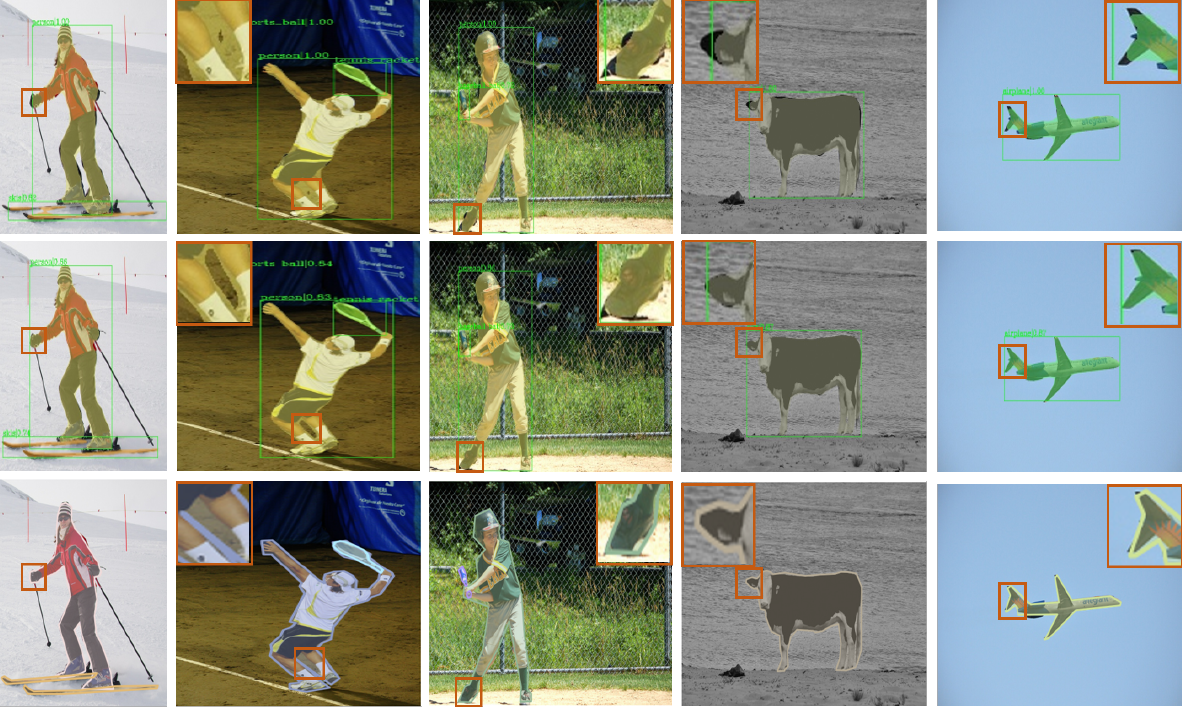
Figure 7. Visualization of the model on the COCO dataset. The first row indicates the Mask R-CNN